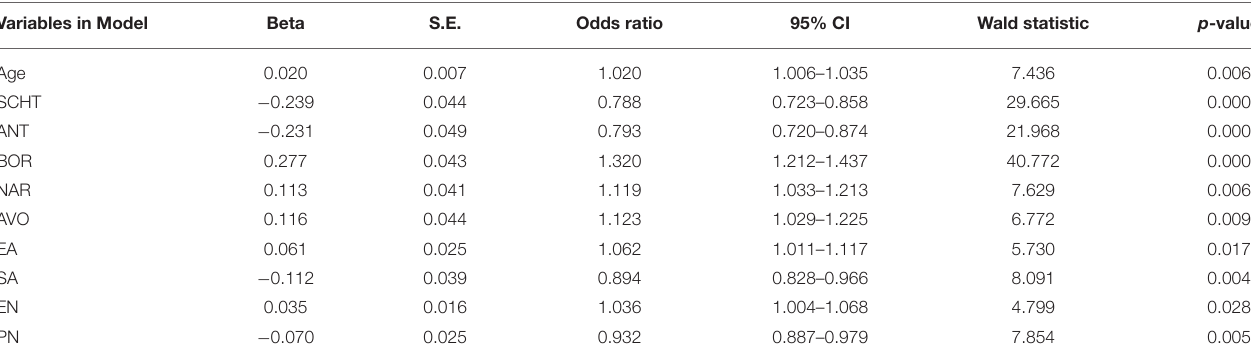
TABLE 5 | Forward stepwise regression for distinguishing between patients with schizophrenia and major depressive